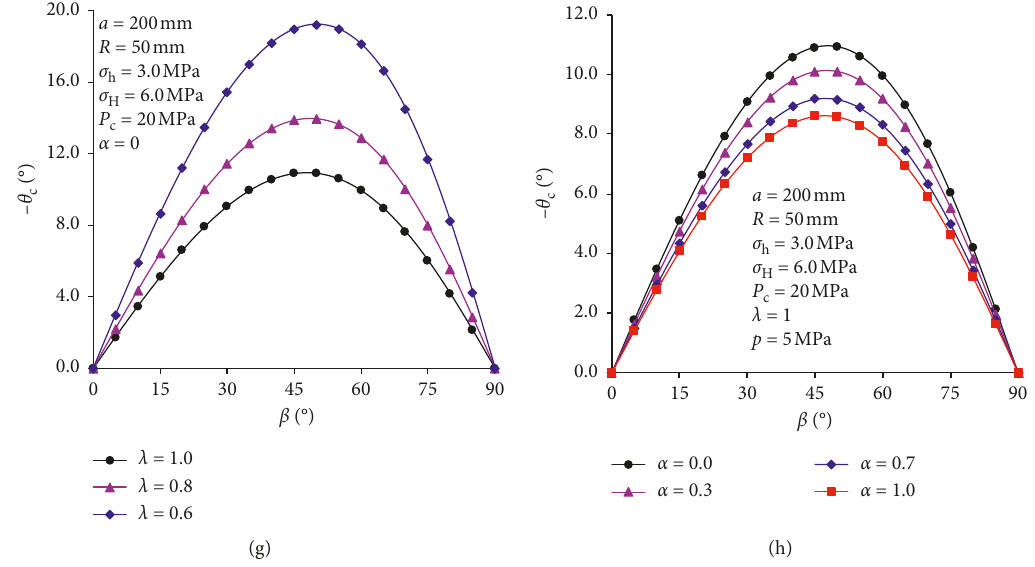
Figure 16: Effect of other factors on the fracture initiation angle under high-pressure water